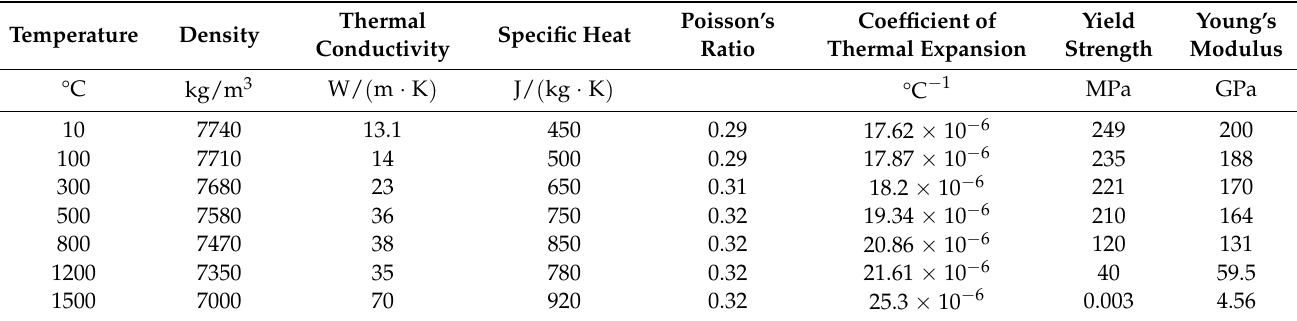
Table 4. Thermal and physical properties of 316L stainless